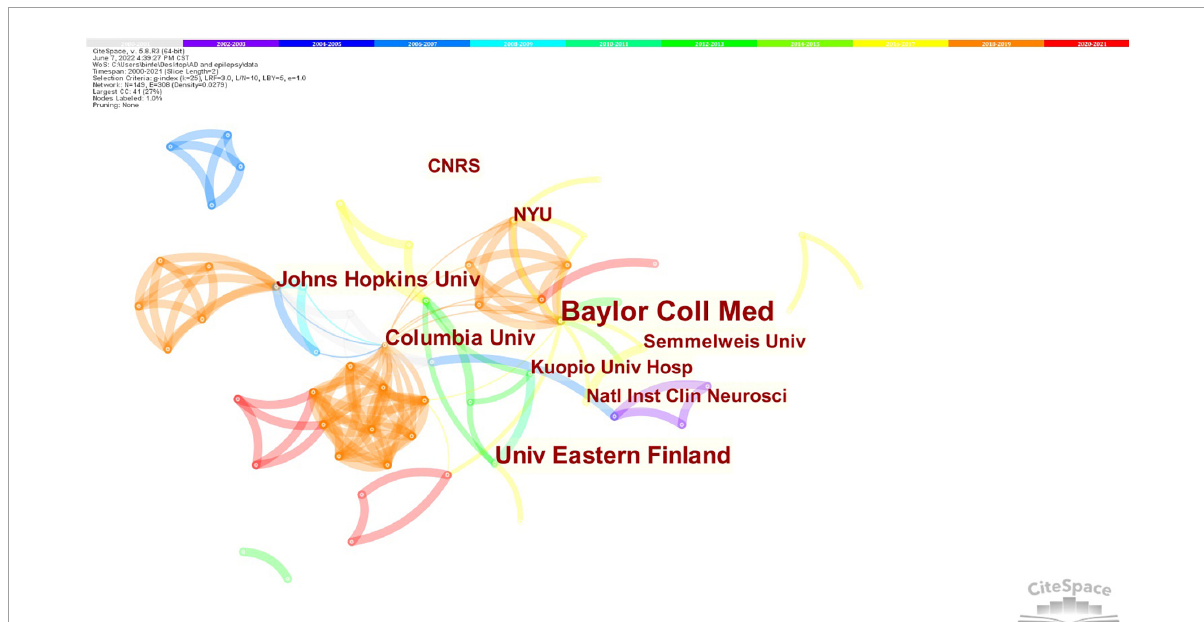
FIGURE5 Contributions of institutions. Nodes represent institutes, and the size of each node corresponds to the co-occurrence frequency of the institutes. The size of the circle represents the number of papers published by the institute. The shorter the distance between two circles, the greater the cooperation between the two institutes. Columbia University was the most influential research